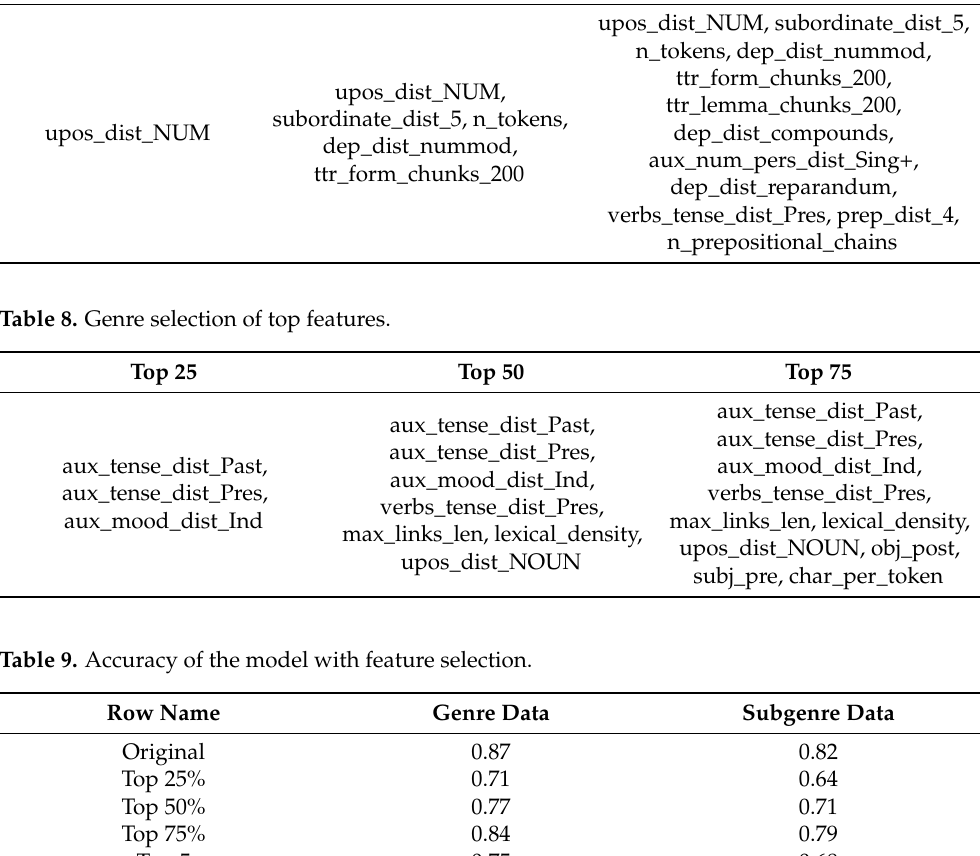
Table 7. Subgenre selection of top features.